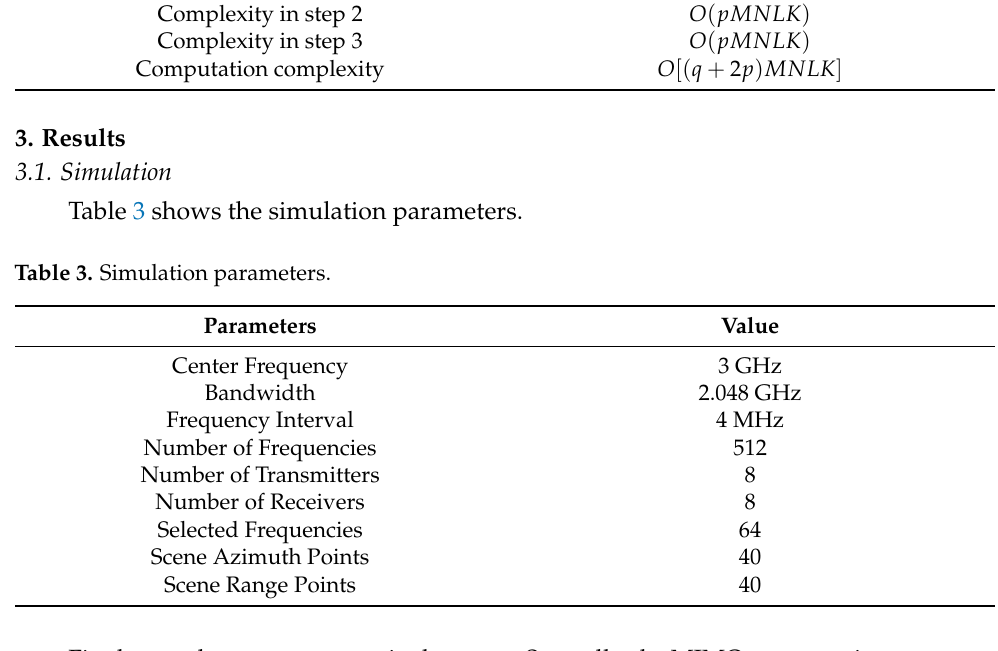
Table 3. Simulation parameters.